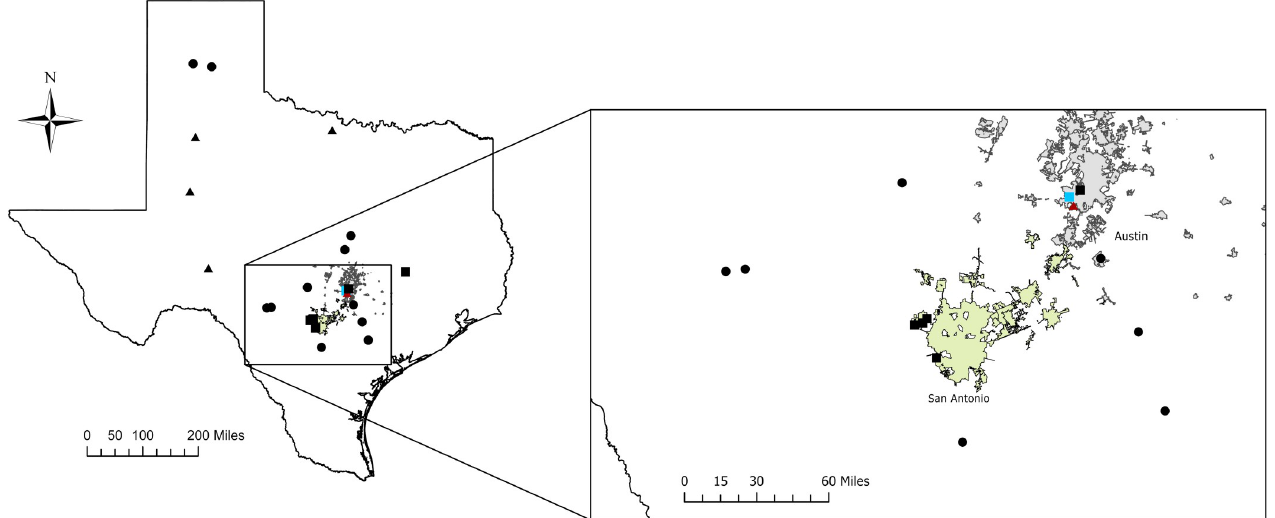
Fig 1. Locality map of Borrelia turicatae sequences and isolates used in the study. Sequences originated from newly acquired isolates (squares), previously published isolates (triangles), and sequences obtained from GenBank (circles). The red triangle in the map denotes three collection sites within a 50-meter proximity and blue square indicates two collections from the same location at two different time points. The city limits of San Antonio and Austin, Texas are shown as green and grey, respectively. Scales are shown in the bottom left of the figure and insert. Below are links to the shapefiles used: State outline: https:// www.arcgis.com/home/item.html?id=9a43e9a3e2df4a159a57bcef5de96018. Austin city limits: https://regional-open-data-capcog.opendata.arcgis.com. San Antonio city limits: https://geoportal-mpo.opendata.arcgis.com.